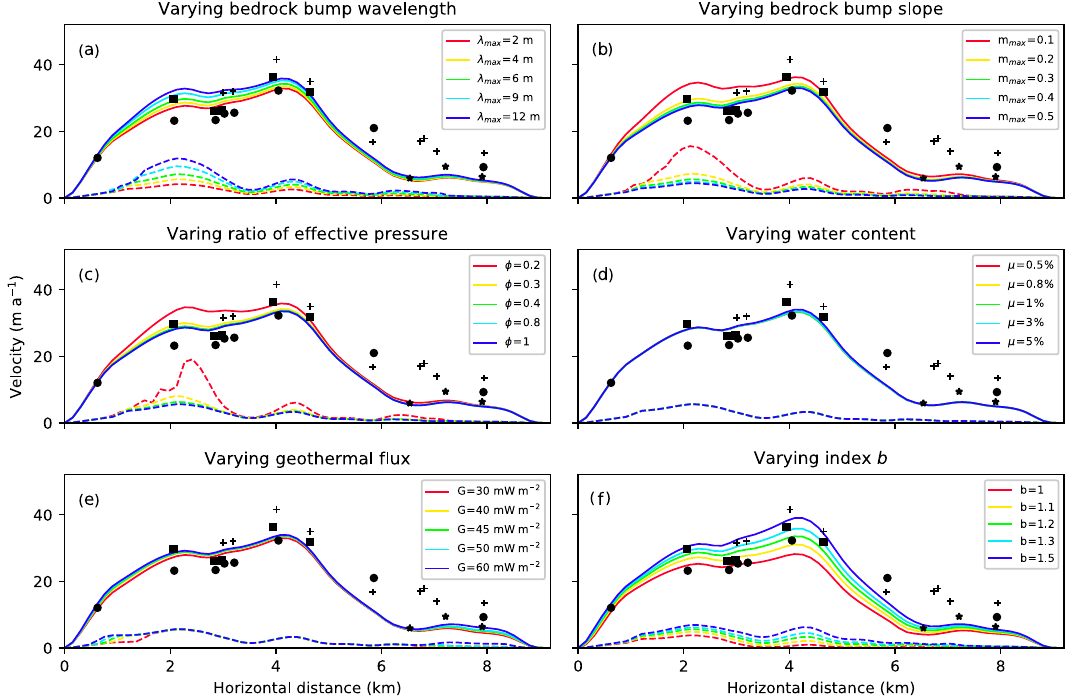
Figure 5. Sensitivity of modelled ice flow speeds to parameters along the CL with default parameters, i.e. λ max = 4m, m max = 0 . 3, φ = 1, µ = 0 . 03, G = 40mWm − 2 , and b = 1 . 2. The solid and dashed lines indicate the modelled surface and basal sliding velocities, respectively. Markers indicate the measured ice surface velocities same as those shown in Fig.